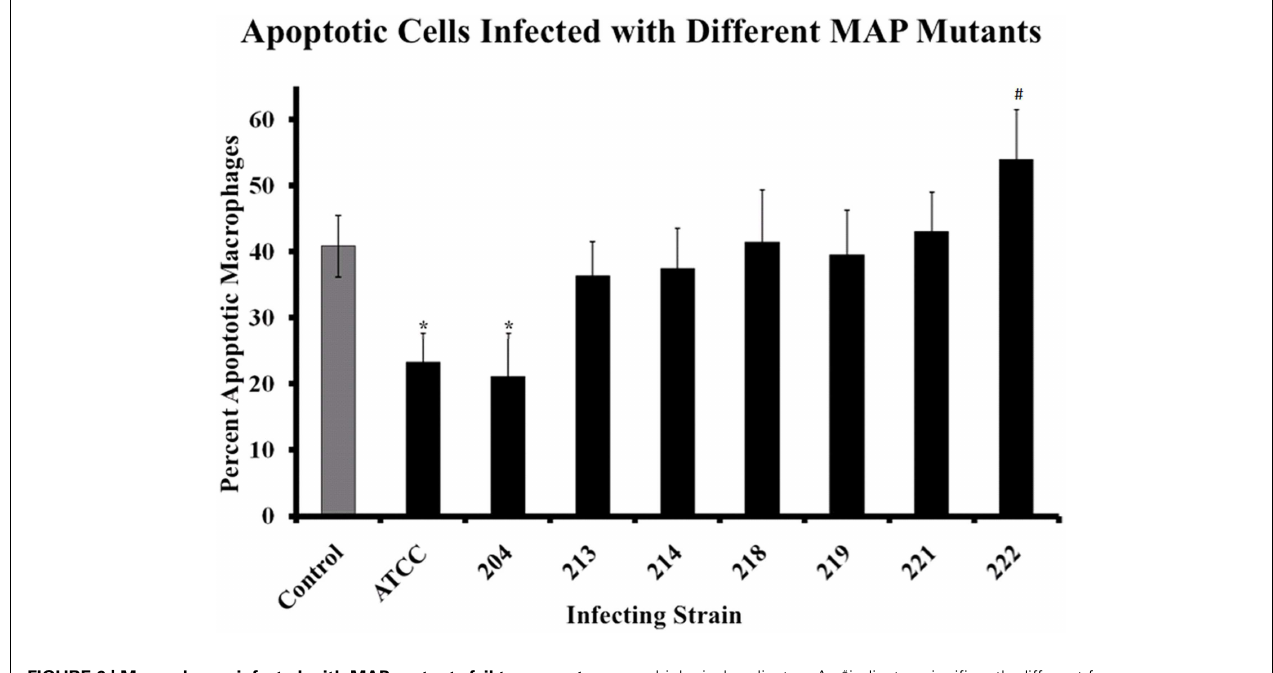
FIGURE 6 | Macrophages infected with MAP mutants fail to prevent host cell apoptosis. The percentage of apoptotic macrophages was determined as described in Materials and Methods. Bars represent the average results of MDM cultured from four healthy Holstein cattle. Error bars represent standard error of the mean (SEM) between the four